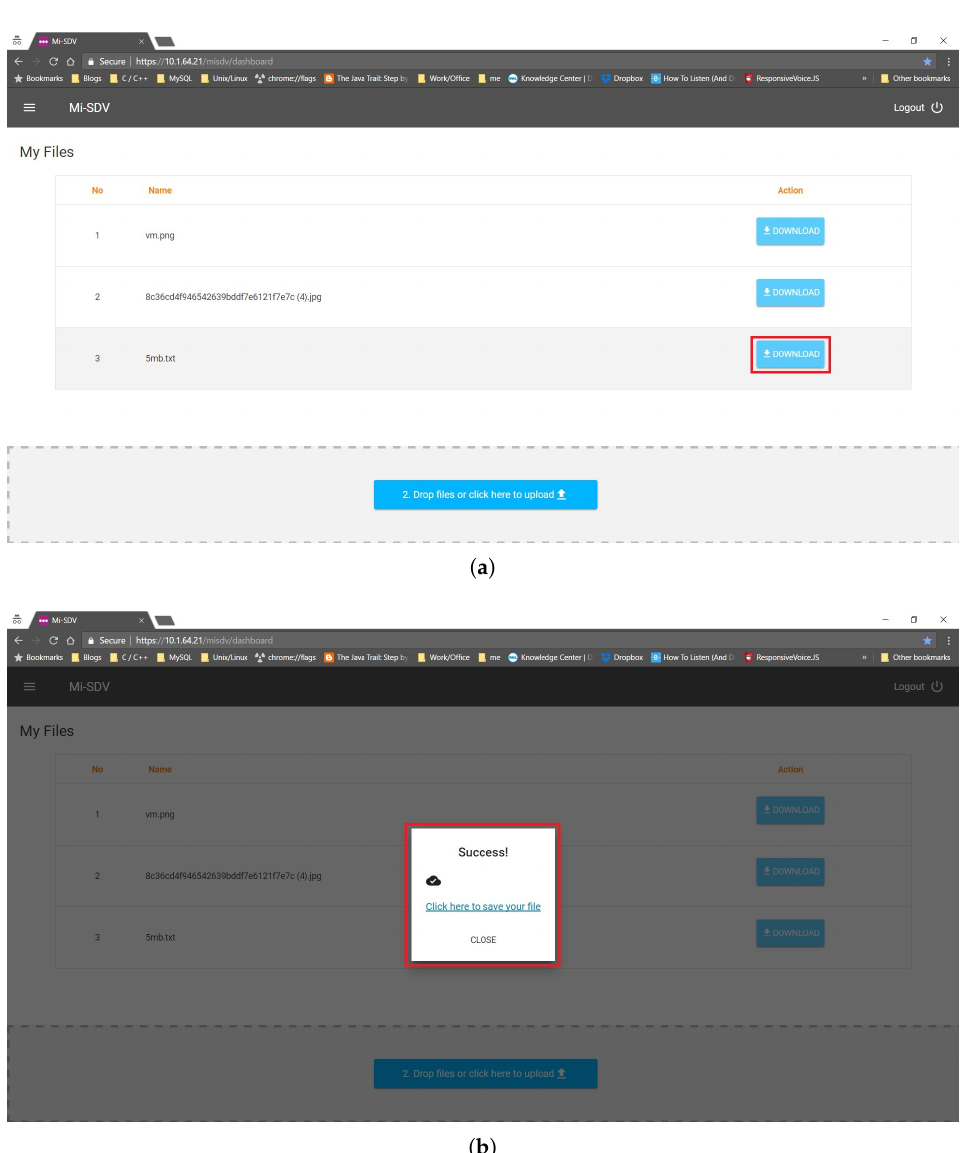
Figure 8. SDV API: How document retrieval is performed (e.g., given four cloud storage servers).